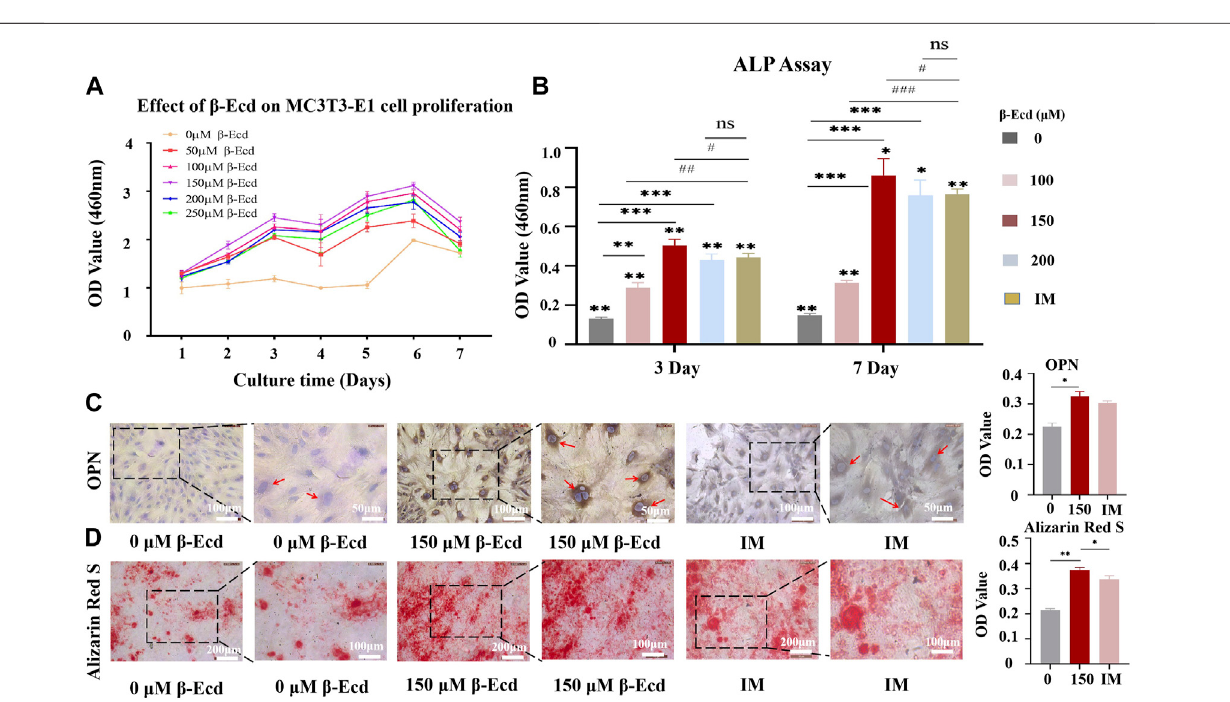
FIGURE 1 | Osteogenic effect of β -Ecd on MC3TE-E1 cells in vitro . (A) The effects of β -Ecd on the proliferation of MC3TE-E1cells. MC3TE-E1 cells were cultured with medium containing 0 μ M β -Ecd (control group) and 50 – 250 μ M β -Ecd (experimental group) and evaluated by the CCK-8 assay. The cell proliferation rate